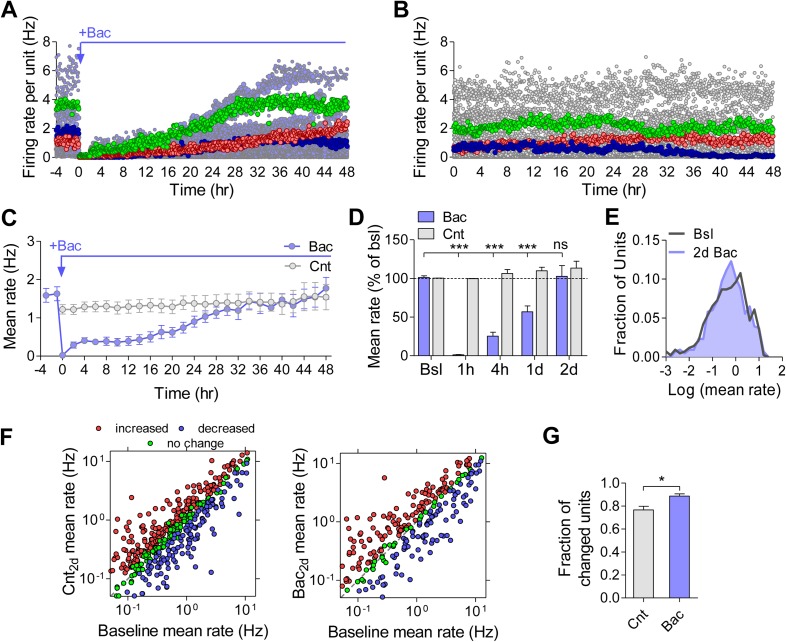
Homeostatic regulation of firing rates is more precise at the network, than the single-unit level.(A) Analysis of the firing rate of each unit in a representative MEA experiment over the course of 2 days of recording in the presence of 10 µM baclofen. Representative units that precisely returned (green), increased (red), and decreased (blue) relative to baseline are highlighted. (B) Analysis of the firing rate of each unit in a representative MEA experiment over the course of 2 days of recording under control conditions. Representative units that didn't change (green), increased (red), and decreased (blue) relative to baseline are highlighted. (C) Mean firing rate of 48 hr control (grey, n = 7) and baclofen (blue, n = 5) MEA recordings. 3 hr of baseline rate are shown for baclofen experiments. (For clarity, only every other hour is shown.) Error bars represent SEM. (D) Statistical comparison of the representative time points (the same data as in C). Error bars represent SEM. (***p < 0.0001, baclofen compared to baseline; all control hours were not significantly changed; repeated-measures ANOVA with Bonferroni's multiple comparison test.) (E) Distribution of unit firing rates (log scale) during baseline and after 2 days in the presence of baclofen. (F) Per unit correlation between baseline firing rates and firing rates after 2 days: Left: control (n = 7; 490 units); Right: in the presence of baclofen (n = 5; 314 units). Colors represent units that significantly increased (red), decreased (blue), or remained stable (green) as determined by bootstrapping (see ‘Materials and methods’ for details). Note log scale of both axes. (G) Summary of data in F (*p < 0.05; unpaired, two-tailed Student's t-test). Error bars represent SEM.